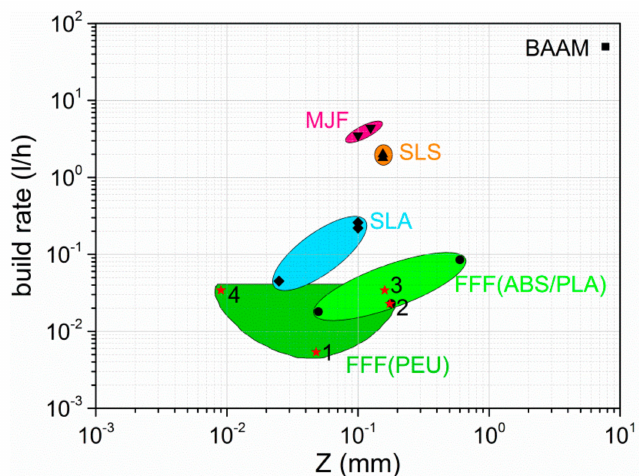
Figure 14. Build rate versus layer thickness for common additive manufacturing processes. The initial data was extracted from Quinlan et al [64]. The red stars represent data points for the QR code elevation as part of the type 1 QR code carrier (1) and the type 2 QR code carrier (2), while the remaining data points refer to the substrate of the type 1 and type 2 QR code carrier (3) and the type 3 QR code carrier